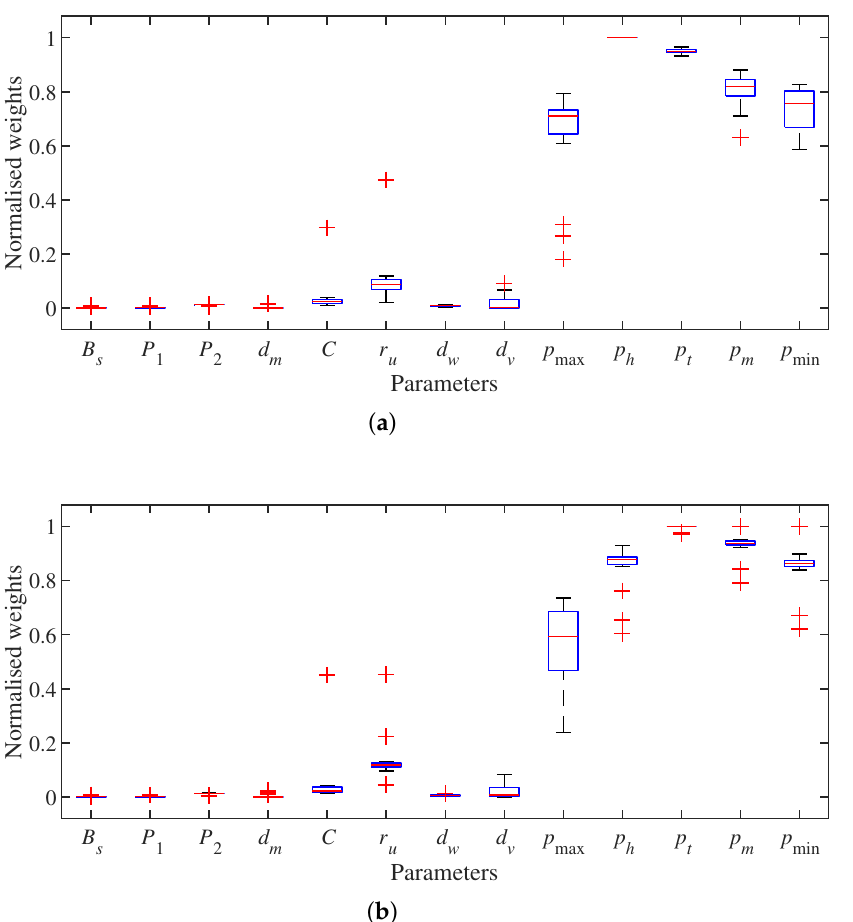
Figure 5. Normalised parameter weights for performance metrics true positive rate (TPR) and false discovery rate (FDR). ( a ) TPR. ( b ) FDR.